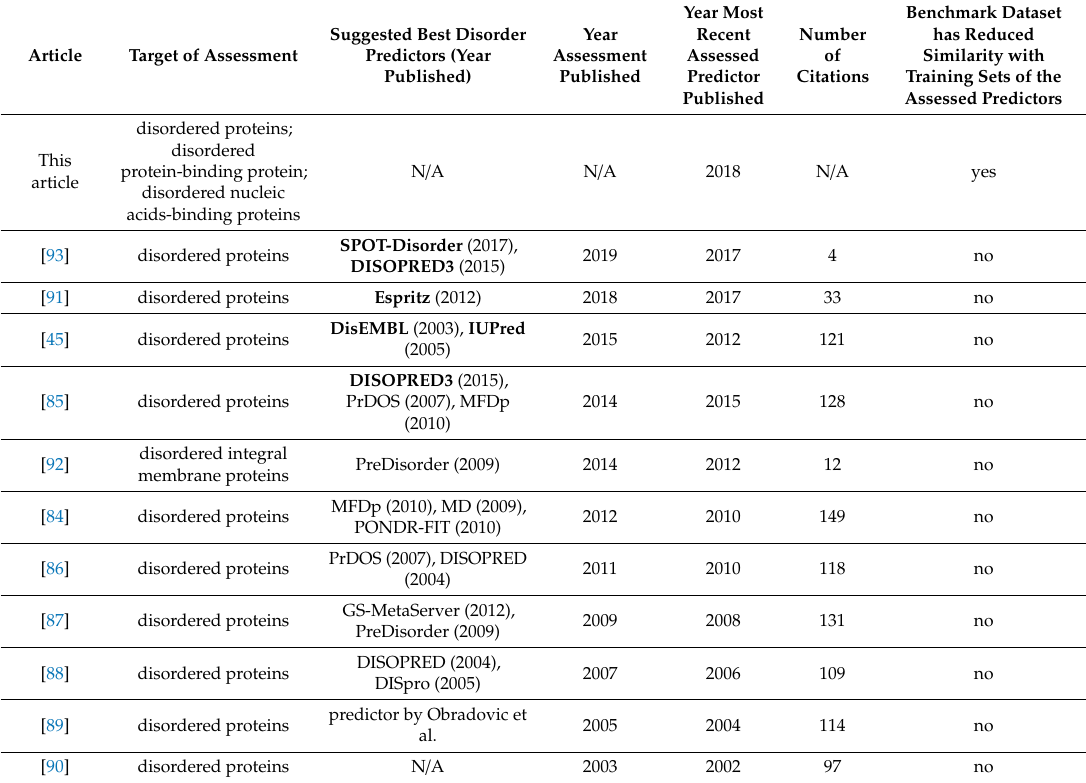
Table 1. Summary of the past comparative assessments of disorder predictors. The articles are sorted chronologically (from the most recent). The citation numbers were collected from Google Scholar on 29 September 2020. Predictors shown in the bold font in the “suggested best disorder predictors” column are included in the comparative assessment in this article.